Question: Give a one-sentence summary of this figure.
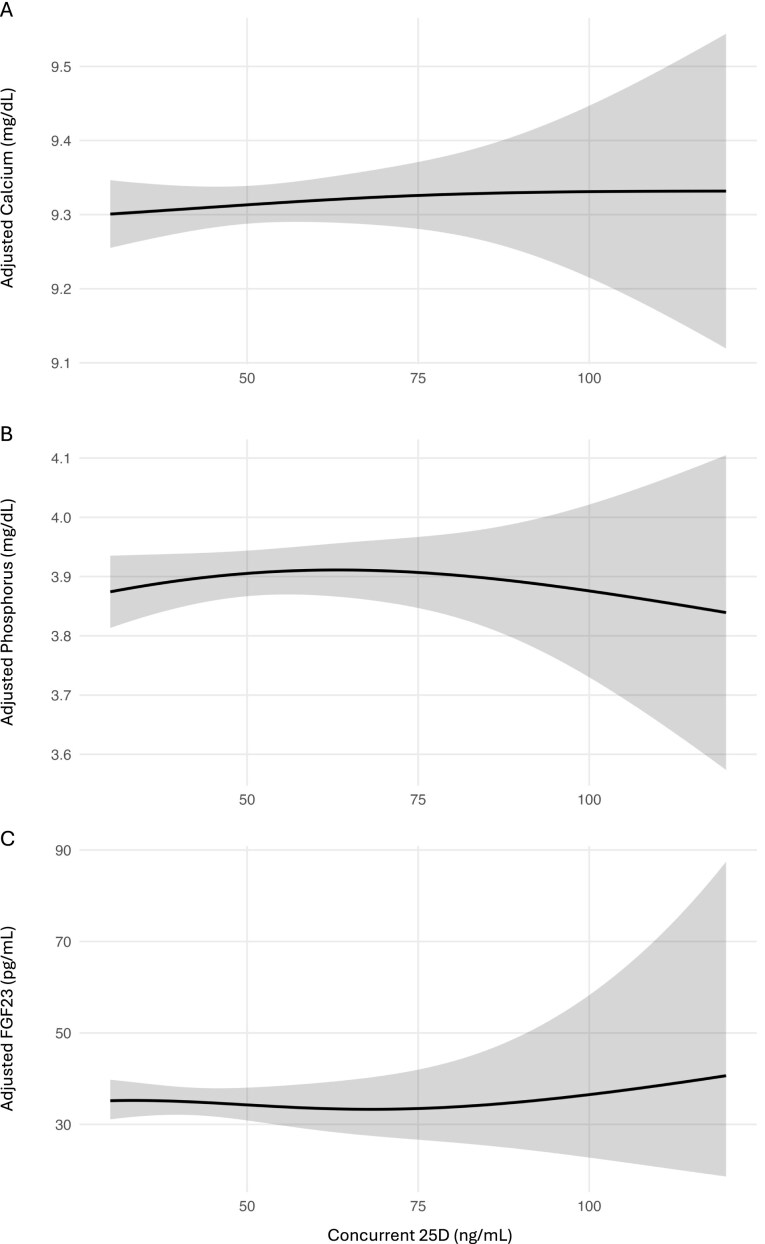
Answer: Population-average adjusted relationships between achieved serum 25-hydroxyvitamin D (25D) concentrations and serum (A) calcium, (B) phosphorus, and (C) fibroblast growth factor 23 (FGF23). Curves represent marginal mean predictions from longitudinal mixed-effects models; shaded bands denote 95% CIs.